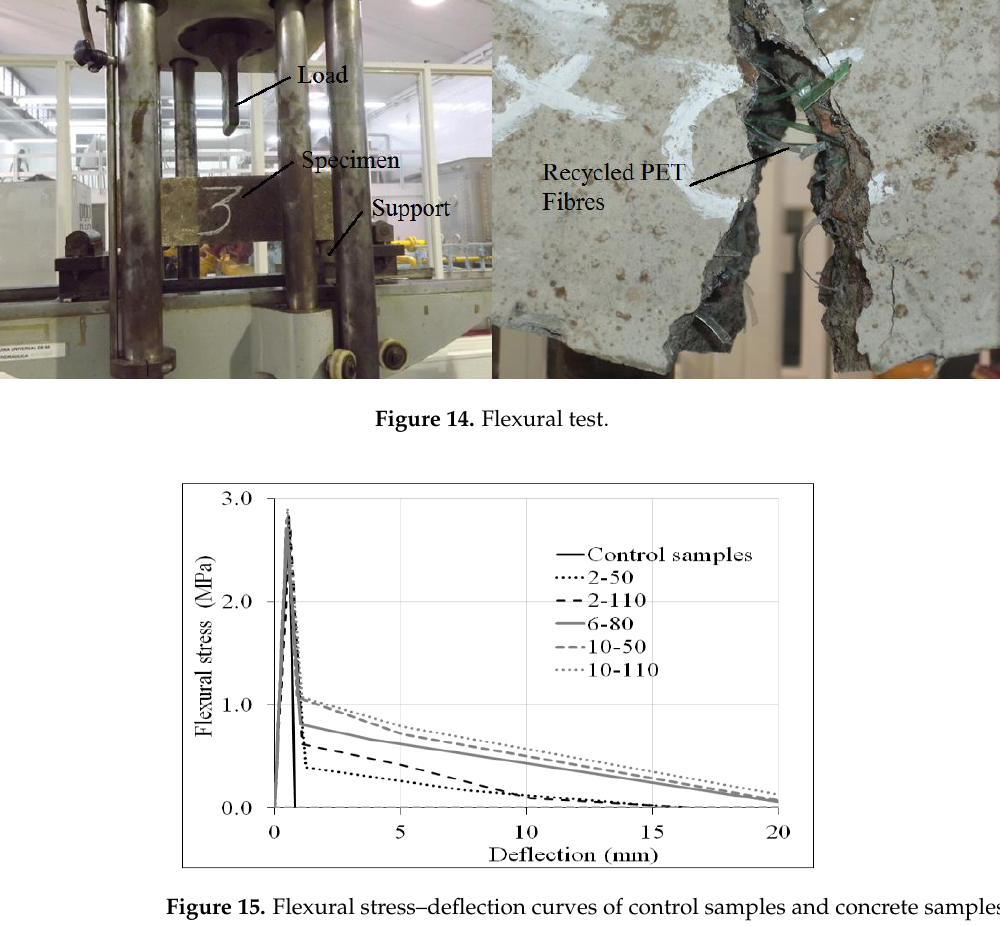
Figure 16. Ultimate flexural strength of control samples and concrete with recycled PET fibres.